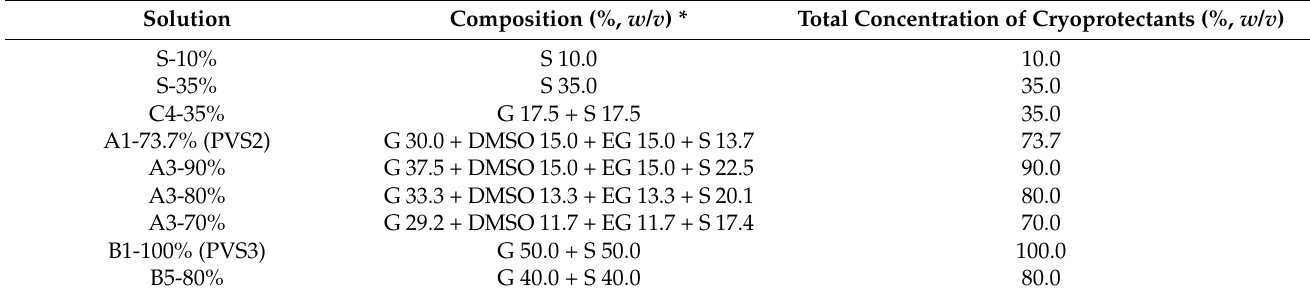
Table 5. Composition of solutions used for preculture, osmoprotection, cryoprotection and unloading.